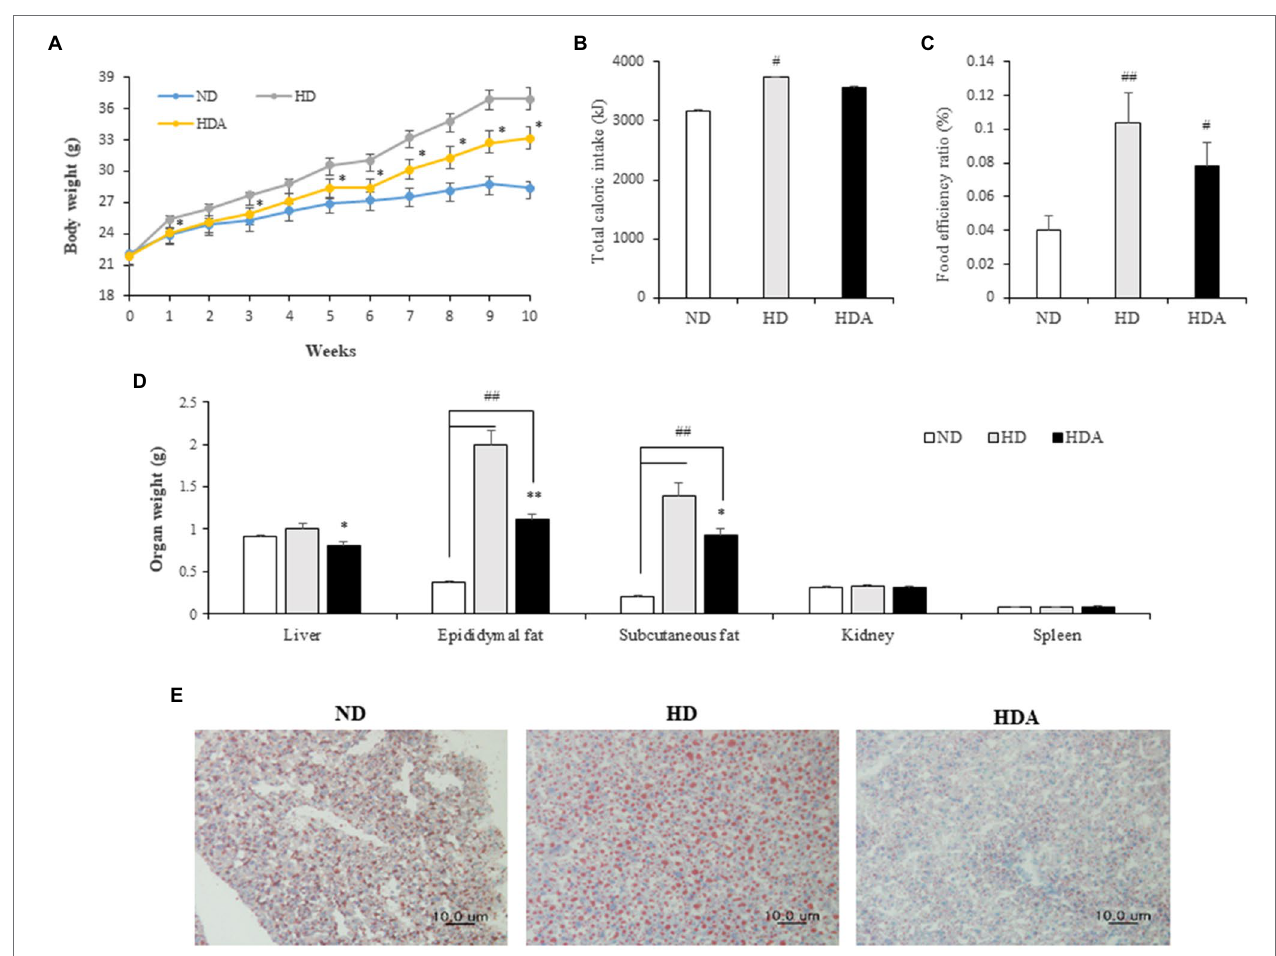
FIGURE 1 | Effect of administering Lactobacillus sakei ADM14 on body indicators in high-fat diet (HFD) mouse model. (A) Weight change of mice groups. (B) Total caloric intake for 10 weeks. (C) Food efficiency ratio (FER) for 10 weeks. (D) Organs weights of mice after sacrifice. (E) Histological analysis of liver stained with Oil Red O. ND, normal diet group; HD, high-fat diet group; and HDA, high-fat diet plus L. sakei ADM14 group. The results are shown as mean ± SEM ( n = 5–7). Significant differences between HD and ND are indicated as # p < 0.05 and ## p < 0.01. Significant differences between HDA and ND are indicated as # p < 0.05 and ## p < 0.01. Significant differences between HD and HDA are indicated as * p < 0.05 and ** p < 0.01.